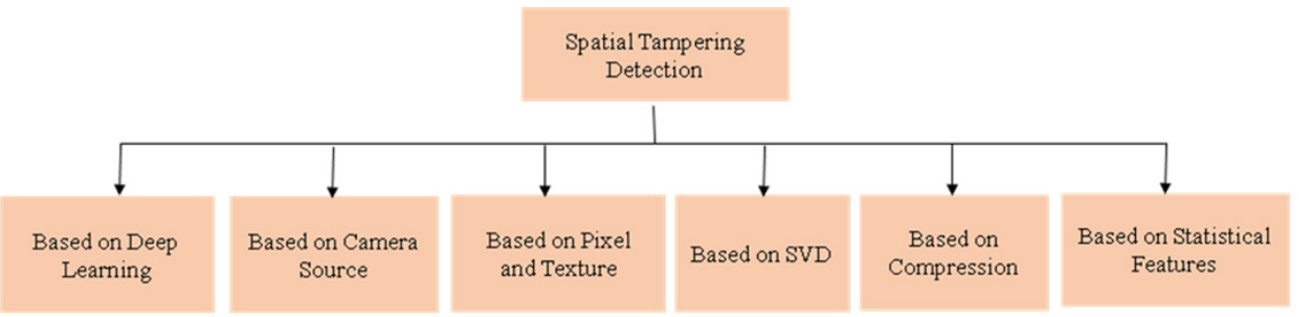
Figure 5. Categories of spatial tampering detection methods.